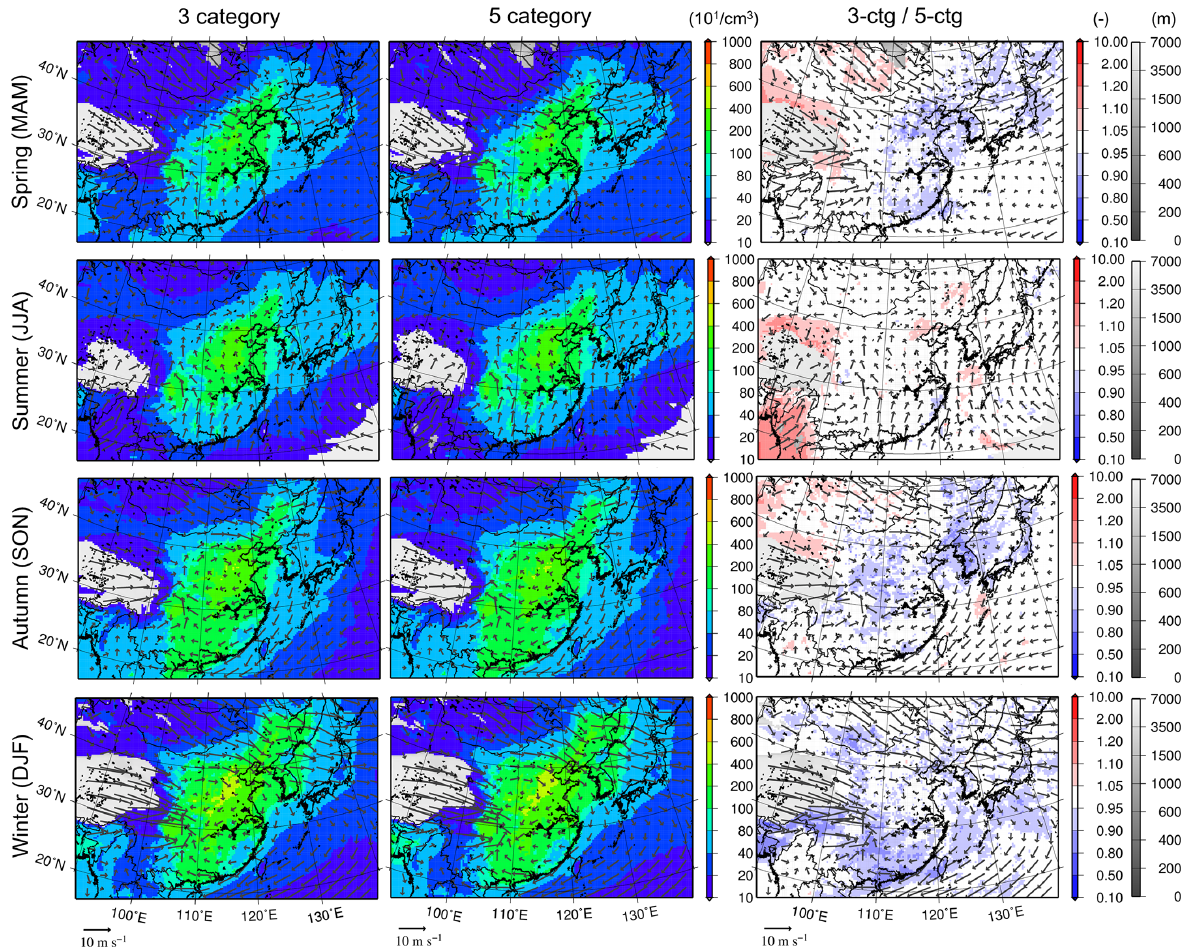
Figure 11. Same as Figs. 9 and 10 but for the averaged CCN number concentration below approximately 1kma.g.l. at a supersaturation of